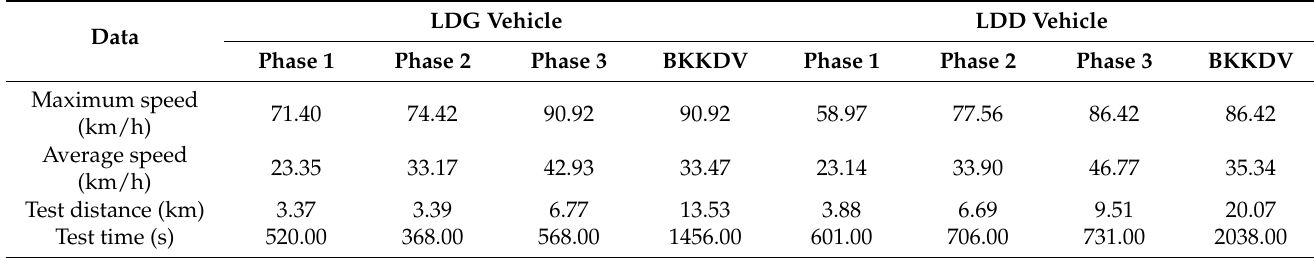
Table 2. The average speed, test distance, and test time of all phases and one driving cycle for LDG and LDD